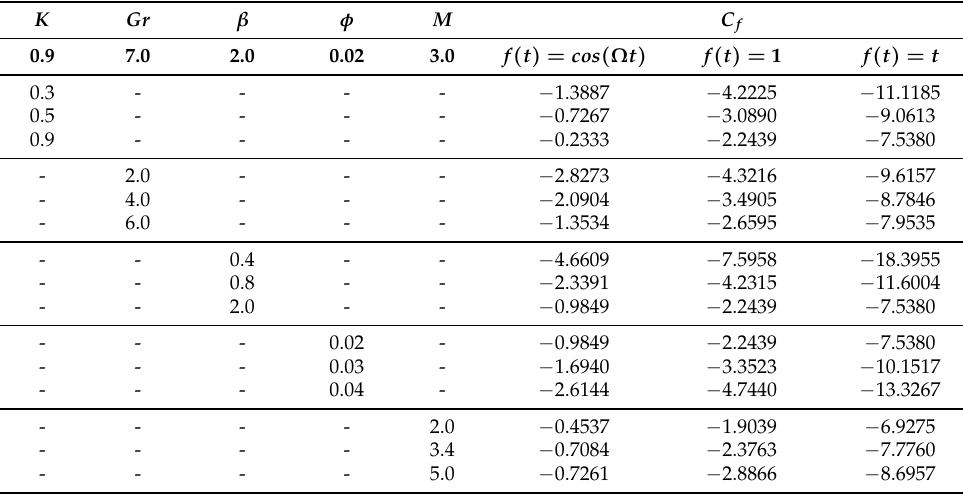
Table 6. Numerical analysis of associated parameter’s impact on skin